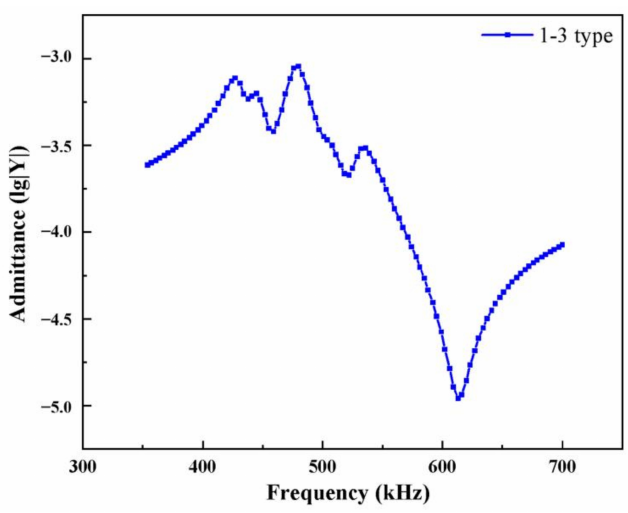
Figure 13. Admittance curves of 1-3 type when coupling harmonics are